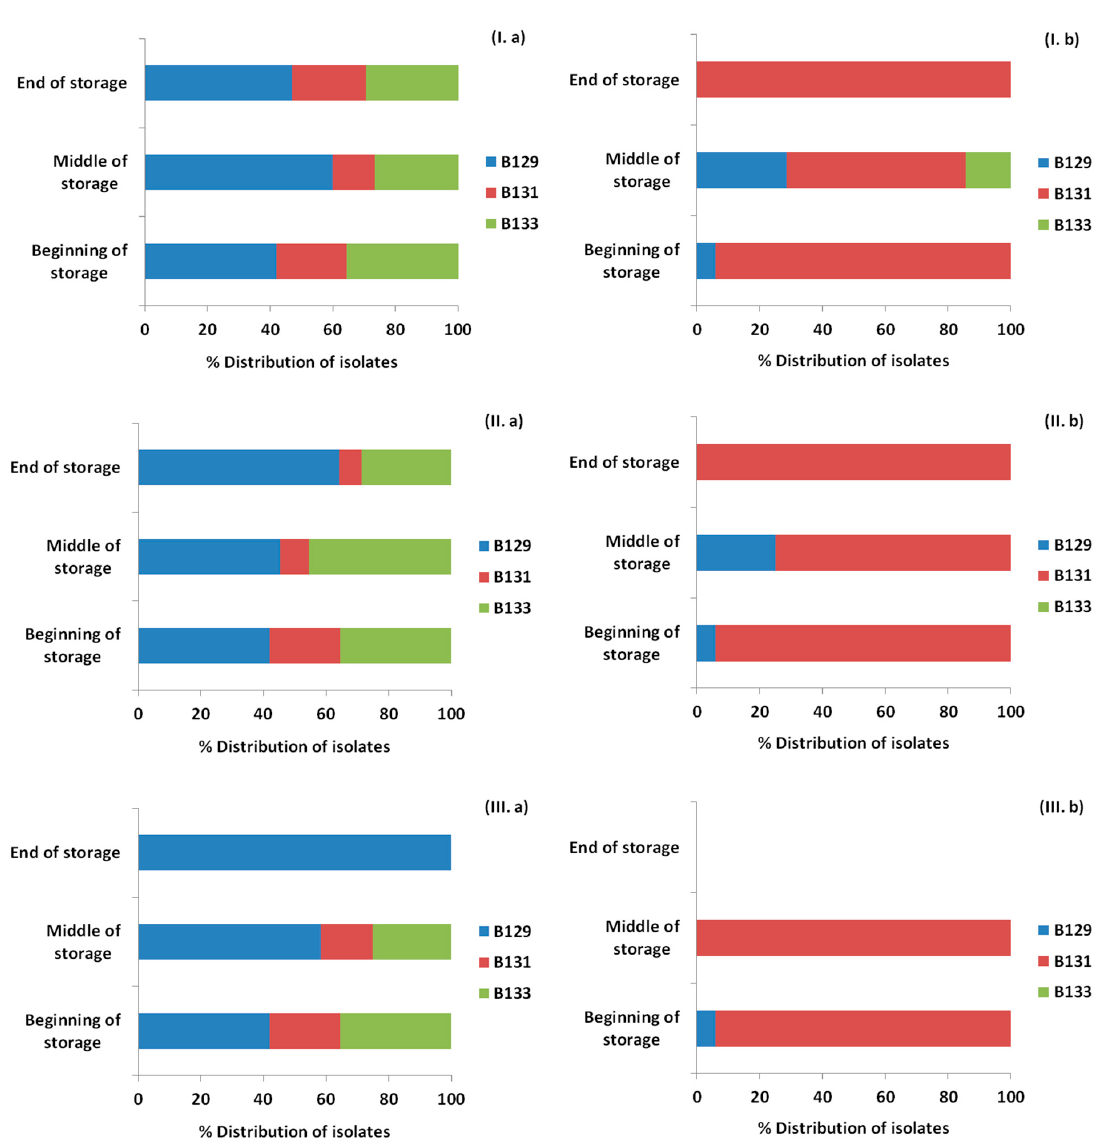
Figure 9. Distribution (%) of Listeria monocytogenes strains recovered from ham slices at three time points (beginning, middle, end) during storage at 8 °C based on the pulsed field gel electrophoresis